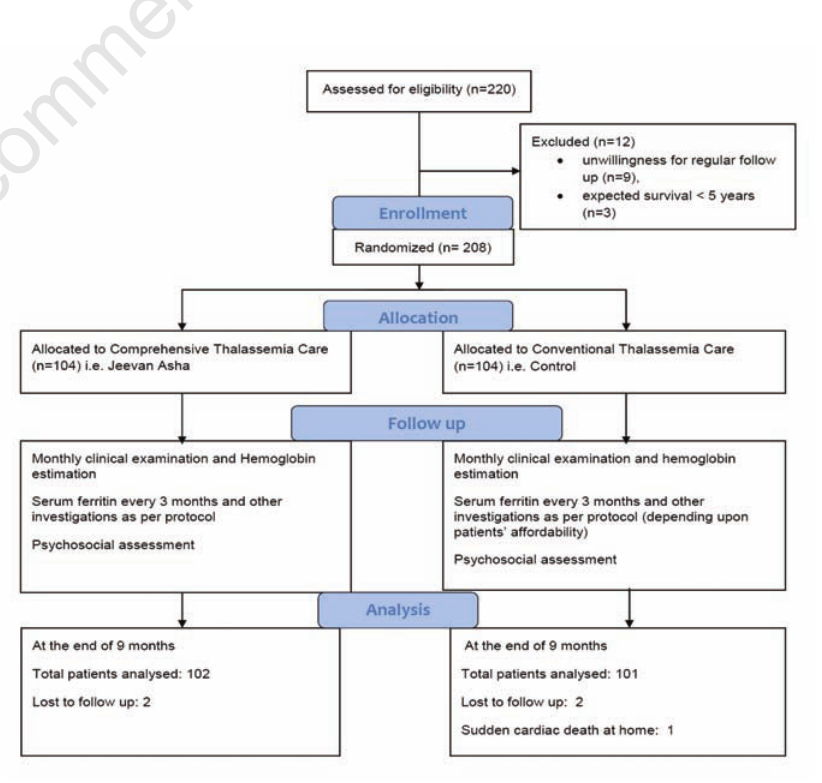
Figure 1. Consort diagram of the